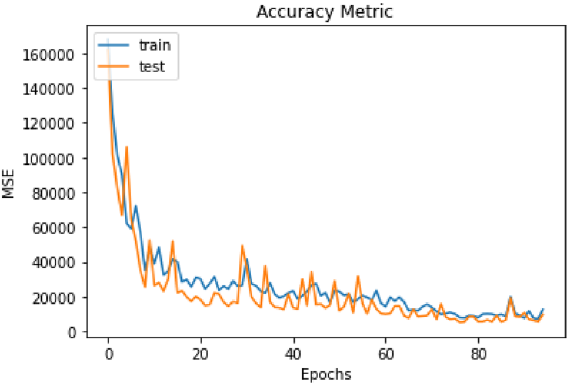
Figure 2. Training rounds compared to the A549 imaging test. In orange, the test line is observed, and in blue, the training. The MSE value decreases (y-axis) after each training round